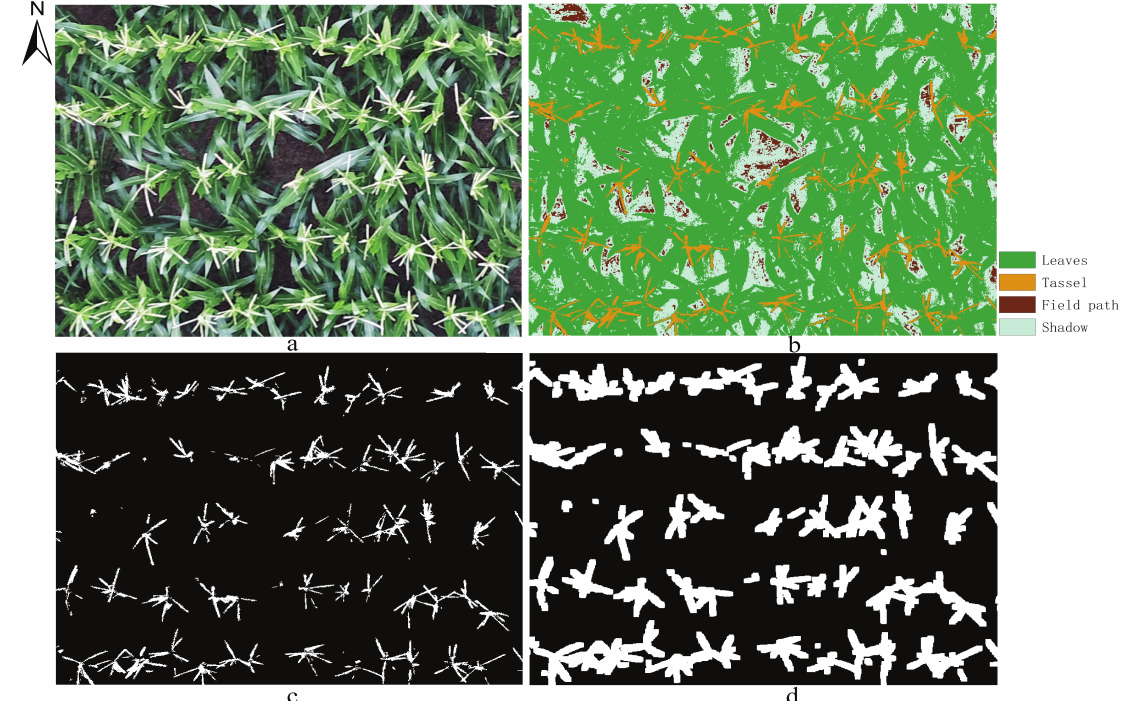
Figure 6. The extraction of potential tassel region proposals. ( a ) Original image. ( b ) Classification result by RF. ( c ) Binary image of tassels (white is tassel regions, black is non-tassel regions). ( d ) Result of morphological dilation (white is tassel regions, black is non-tassel